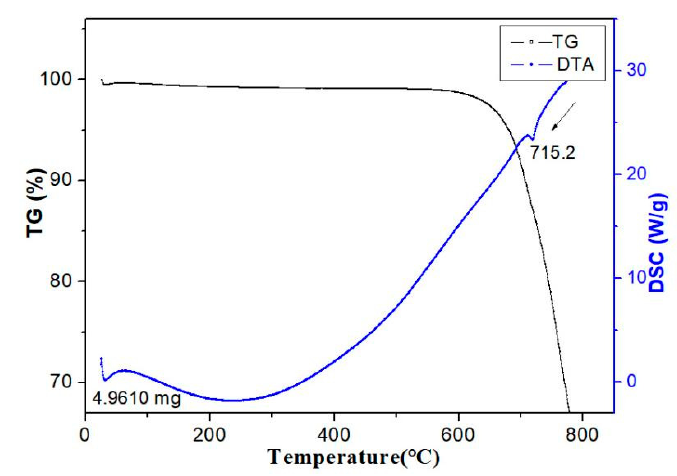
Figure 1. The TG/DSC curves of AGGSe crystal.